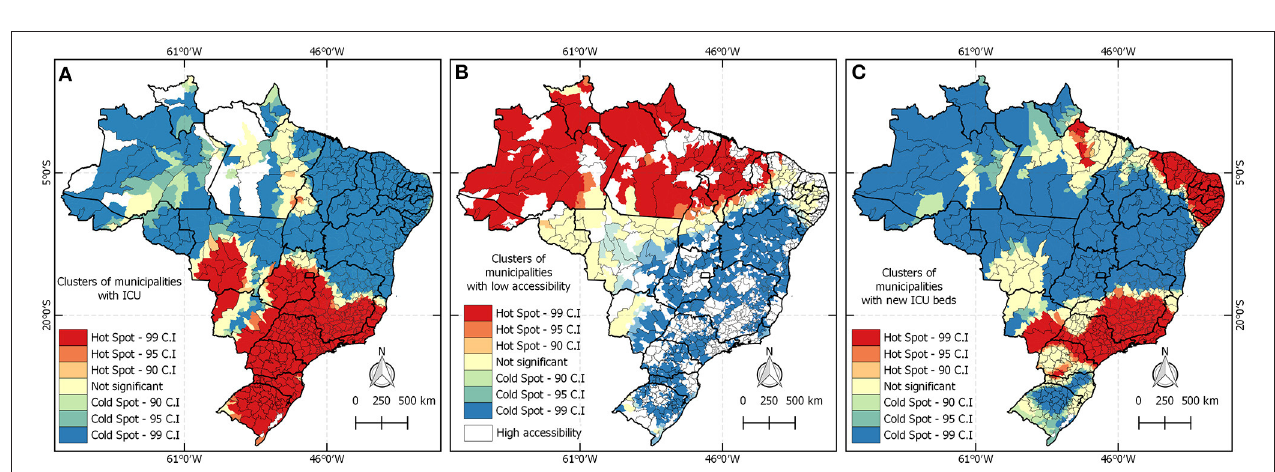
FIGURE 7 | Spatial clusters of access to ICU beds dedicated to tackling COVID-19 in 2020 in Brazil. (A) Shows the accessibility index in February 2020. (B) Presents the high incidence of the disease and the lack of emergency care services. (C) Exhibits clusters of accessibility index of new beds created until June